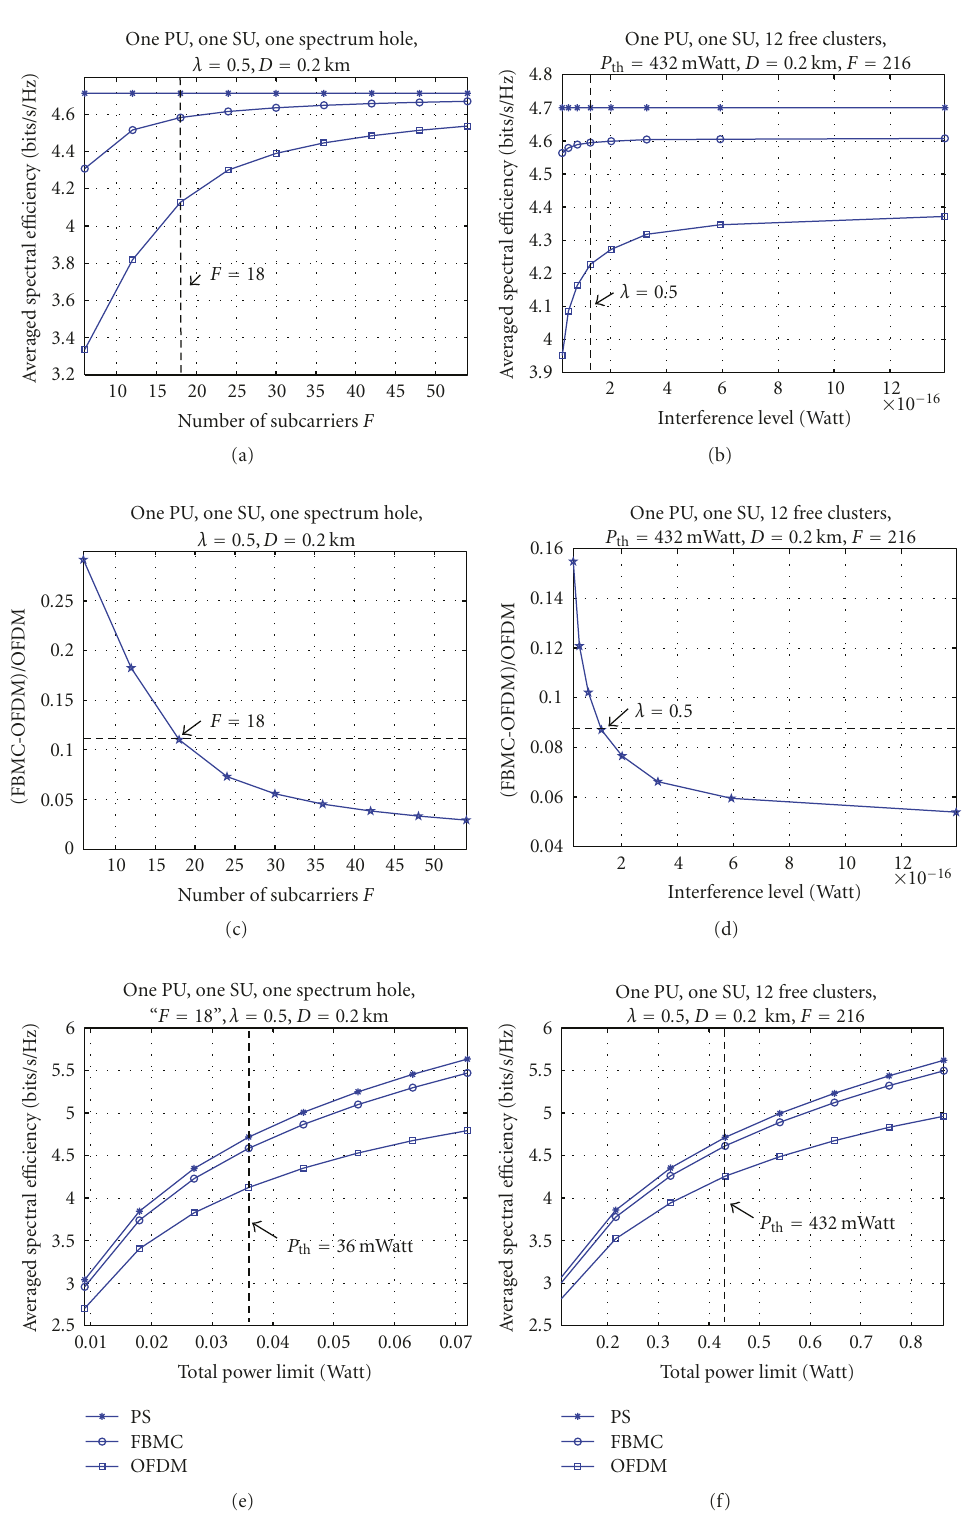
Figure 7: Experimental results of single-user resource allocation for one and multiple spectrum holes with D = 0.2 km: (a) Averaged spectral e ffi ciency versus number of subcarriers for one spectrum hole case. (b) Averaged spectral e ffi ciency versus interference level for multiple spectrum holes case. (c) (FBMC-OFDM)/OFDM versus number of subcarriers for one spectrum hole case. (d) (FBMC-OFDM)/OFDM versus interference level for multiple spectrum holes case. (e) Averaged spectral e ffi ciency versus total power limit for one spectrum hole case (f). Averaged spectral e ffi ciency versus total power limit for multiple spectrum holes